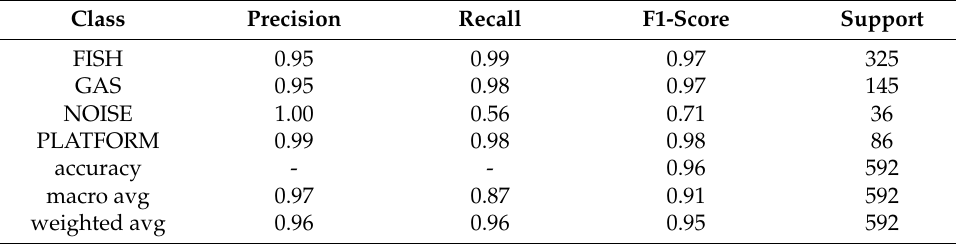
Table 4. Classification report for the ensemble model.